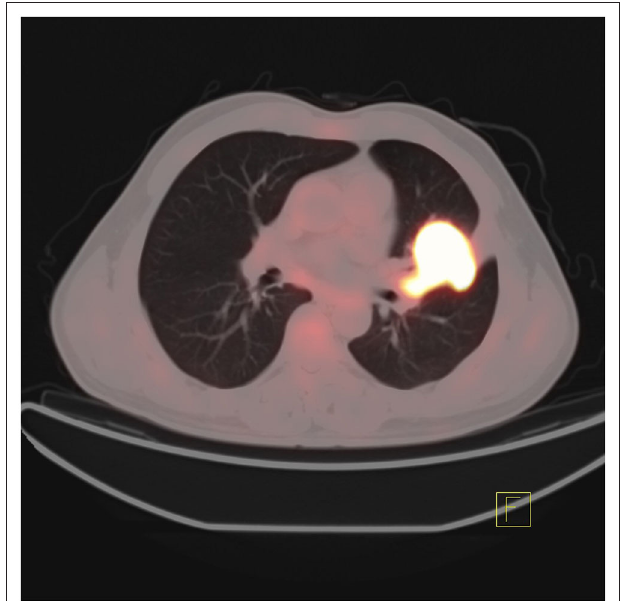
FIGURE 4 | PET/CT manifestations of lung adenocarcinoma patients with EGFR mutation.